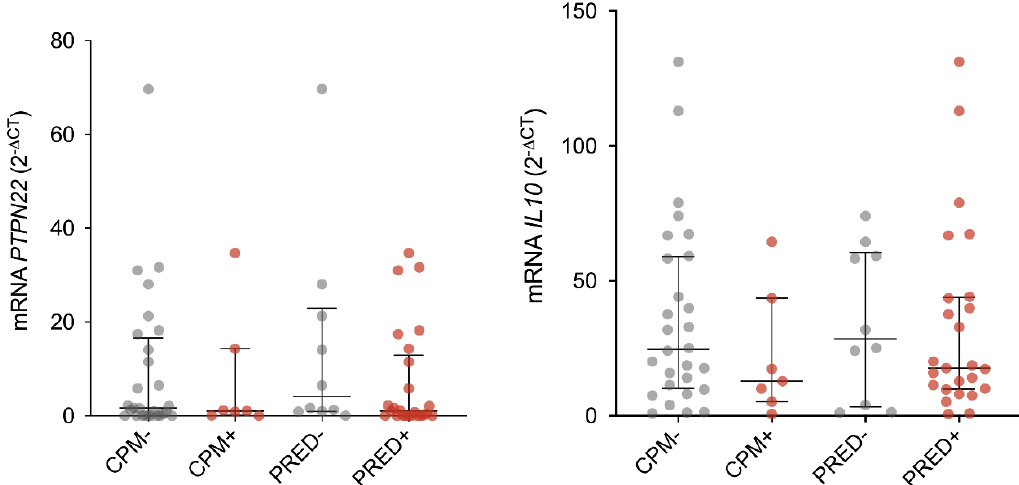
Figure 4. PTPN22 and IL10 mRNA expression according to SLE patient’s treatment. The figure shows the levels of PTPN22 and IL10 mRNA stratified by the use cyclophosphamide (CPM) or prednisone (PRED) in SLE patients. Data are presented in median (p25–p75). Statistical comparisons between groups were determined using the Mann – Whitney U test.